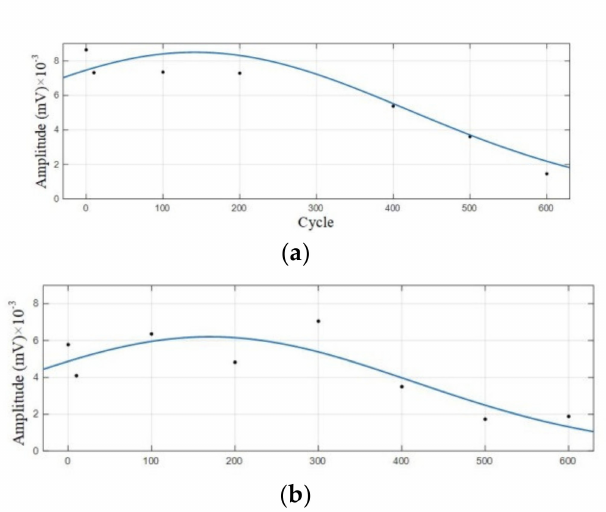
Figure 9. Amplitude variation curve of the 0–600 cycles of Group A batteries. ( a ) Amplitude variation curve with a dominant frequency of 60 kHz; ( b ) Amplitude variation curve with a dominant frequency of 88 kHz.